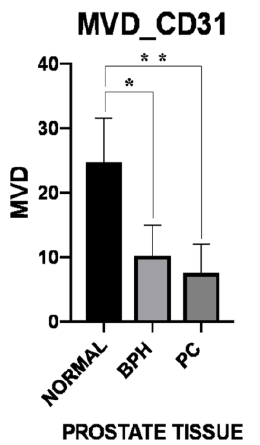
Figure 3. Microvessel density (MVD) based on CD31 immunostaining in prostate samples. The